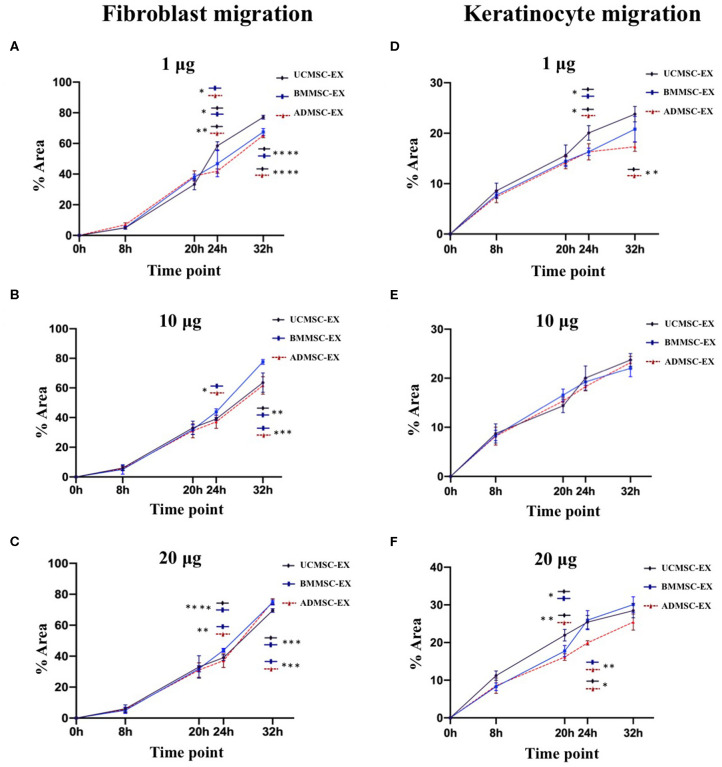
Primary dermal fibroblast and keratinocyte migration under stimulation of exosomes released from BMMSCs, ADMSCs, and UCMSCs. Exosomes released by three cell sources were added to scratched primary dermal fibroblast and keratinocyte cultures to final total exosomal protein concentration of 1 μg (A,D), 10 μg (B,E) or 20 μg (C,F) / 0.1 mL depleted culture media. The primary fibroblasts and keratinocytes were incubated at 5% CO2 and 37°C and allowed to migrate with images captured at different time points. Image analysis was performed using ImageJ and data are presented as mean percent area of wound coverage in μm2 ± SD, from at least 3 independent biological replicates. Data showed that BMMSC-derived exosomes exhibited a greater induction on fibroblast migration within the doses of 10 and 20 μg (B,C), whereas UCMSC-derived exosomes exhibited the greater induction on fibroblast migration within the dose of 20 μg exosomal protein (A). Regarding to keratinocyte migration, UCMSC-derived exosomes showed a strongest stimulation on cell migration (D,F), in addition to the higher doses of exosomal protein derived from all three MCSs exhibited the higher stimulation on keratinocyte migration. Statistical significance was determined by ANOVA and post-hoc Tukey HSD tests, and is indicated by: * where p < 0.05; ** where p < 0.01; *** where p < 0.001; **** where p < 0.0001. BMMSC-EX, BMMSC-derived exosomes; ADMSC-EX, ADMSC-derived exosomes; UCMSC-EX, UCMSC-derived exosomes.